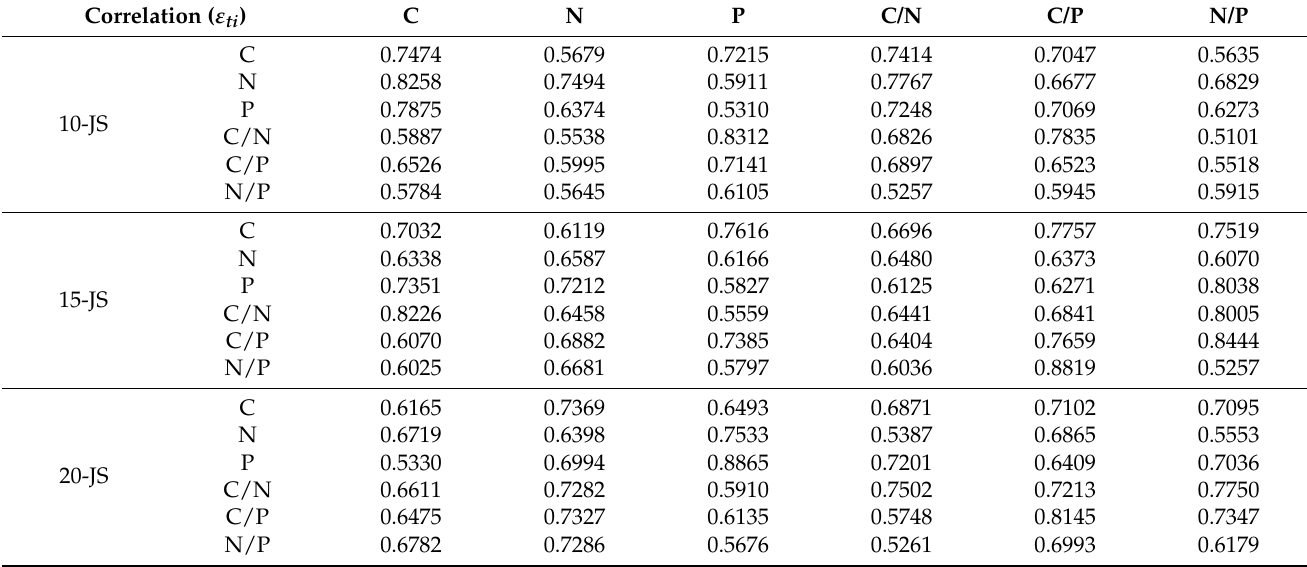
Table 1. Correlation between soil factors and Cynodon factors under different precipitation